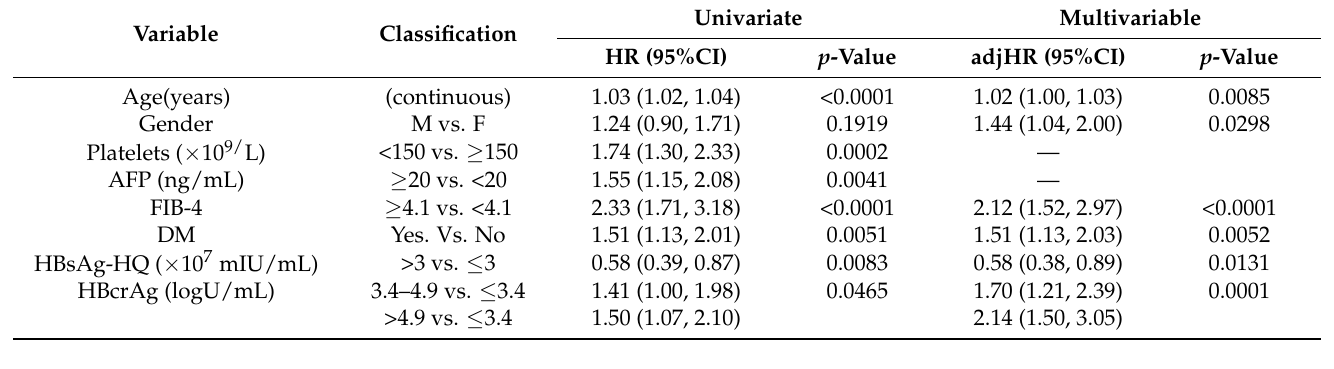
Table 3. Univariate and multivariable analysis for risk factors associated with the development of hepatocellular carcinoma in patients with a virological response.